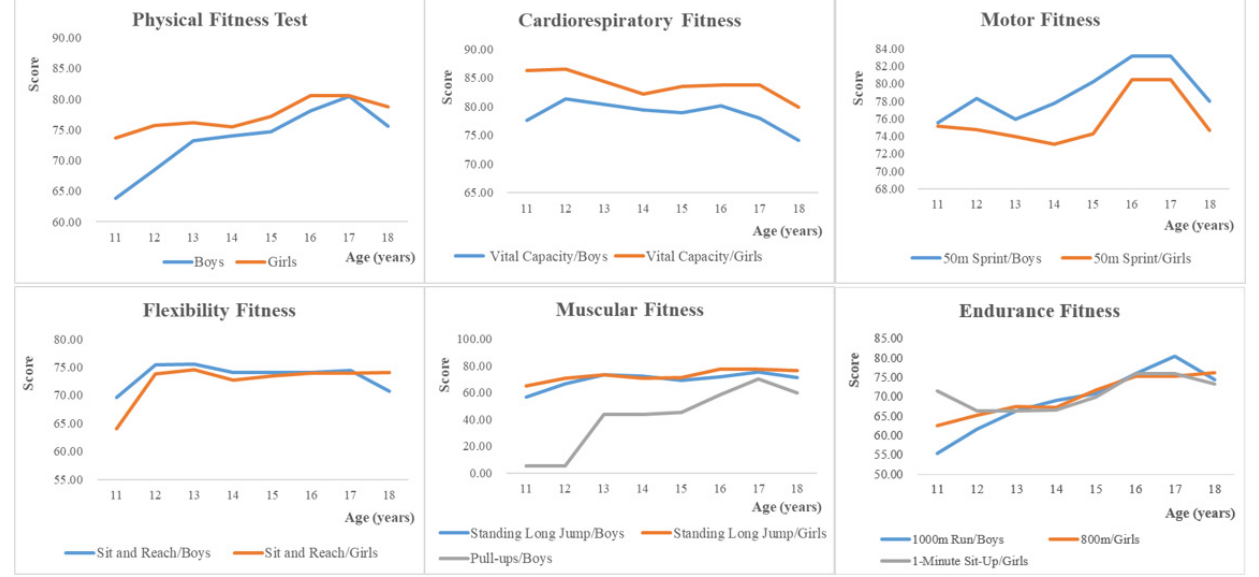
Figure 2. Age-related differences in different physical fitness tests expressed as standardized scores.